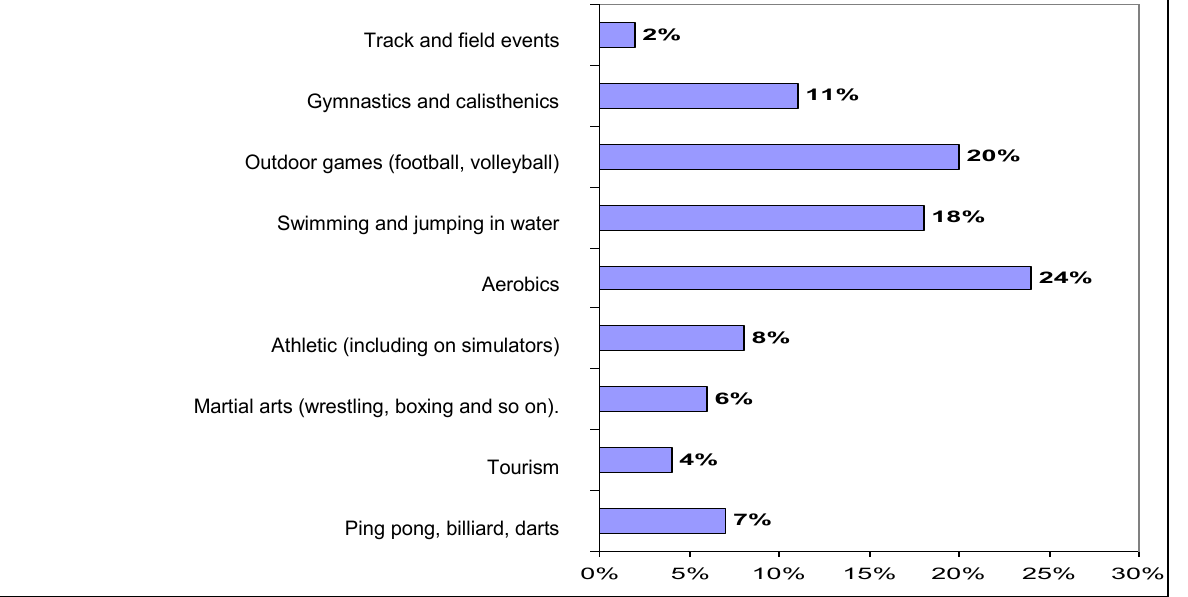
Fig.11. Kinds of physical exercises, preferred by students at physical culture